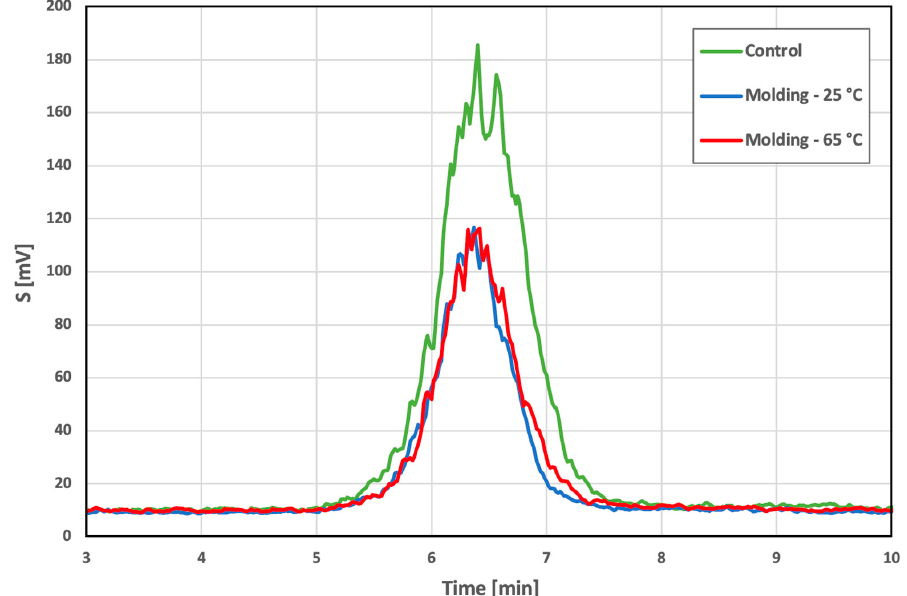
Figure 8. GPC chromatograms of the PDO molded samples: control (PDO granulate), molding − 25 °C and molding − 65 °C. Table 3. The molar masses of the PDO prior to (granulate) and following molding: retention time − T r ,